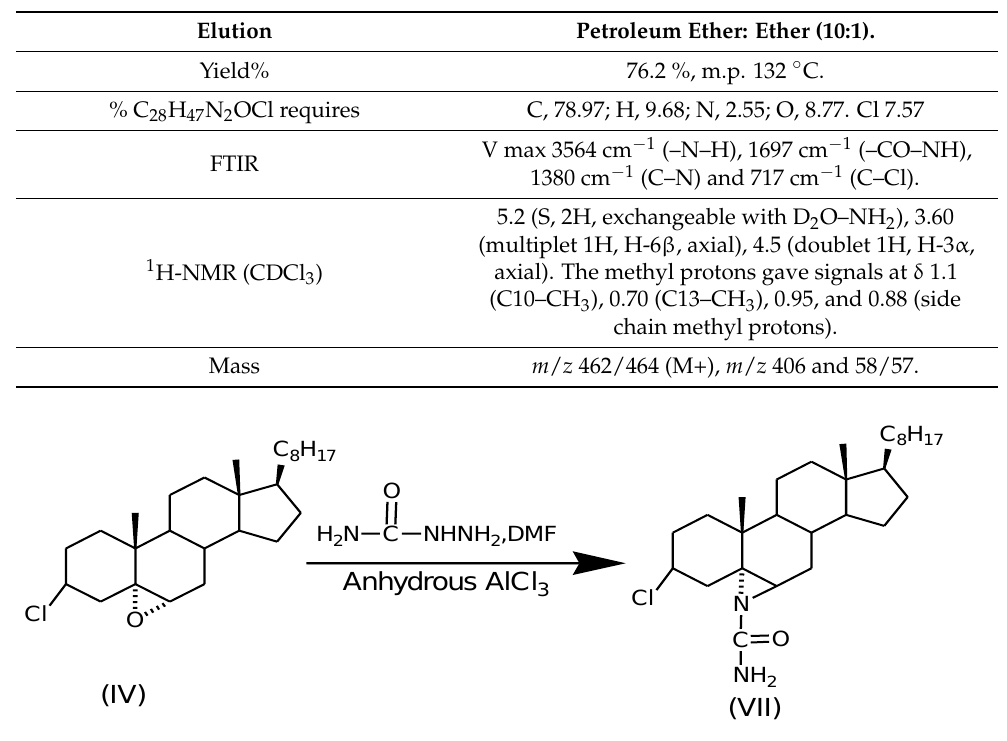
Table 3. FTIR, 1HNMR and mass analyses of 3β -chloro-N-amido- 5α -cholestano-aziridine ( VII ).